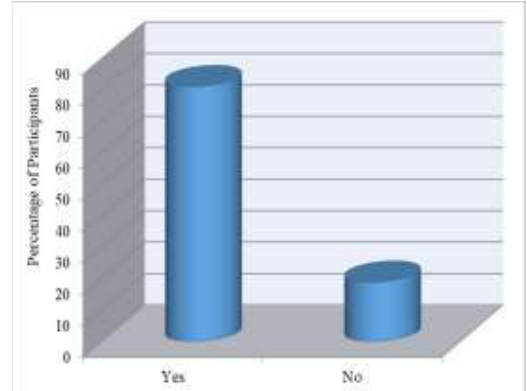
Figure 4. Percentage of participants trusting the drug information gained from the internet and forward them to the patients.